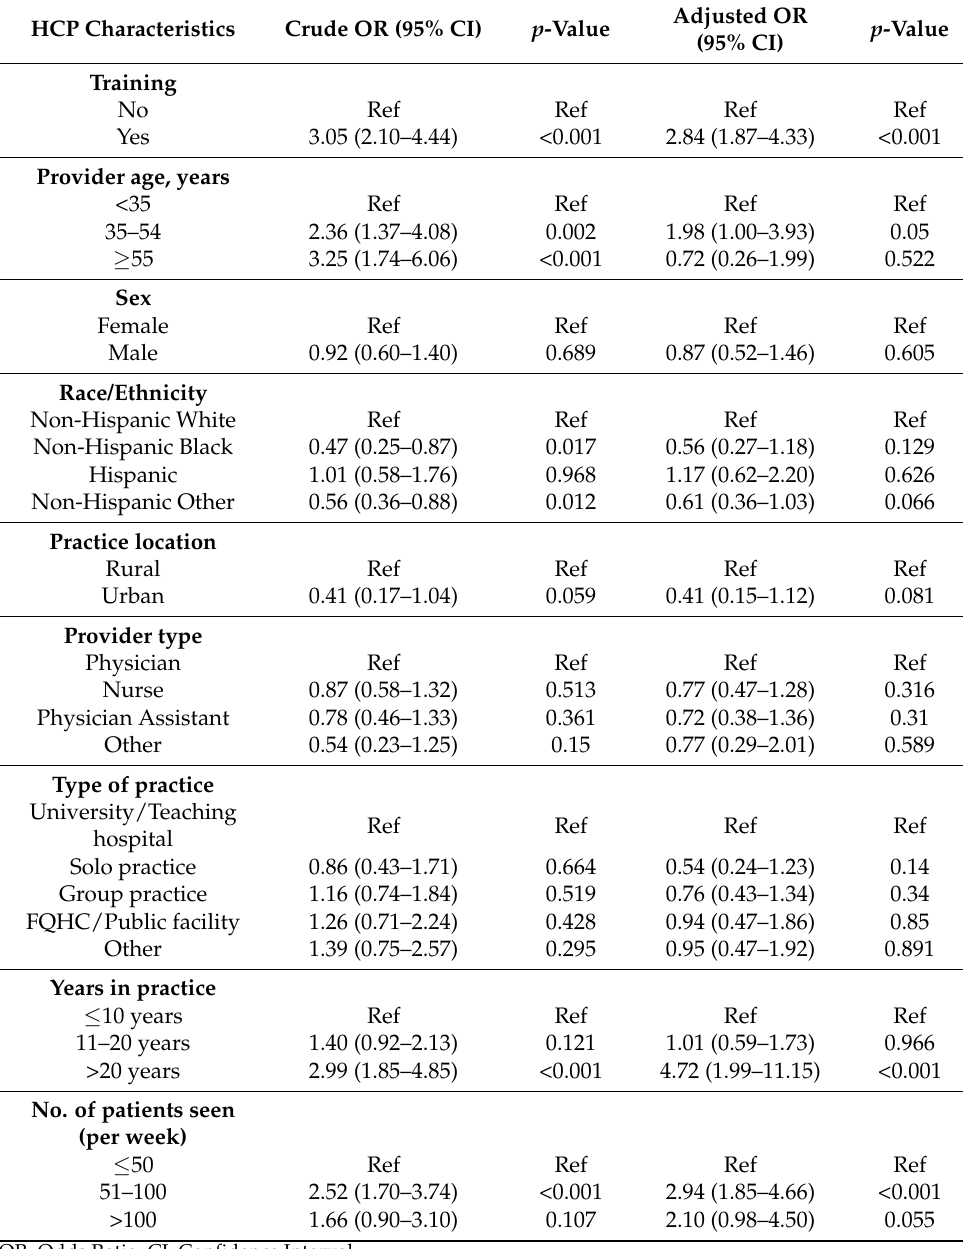
Table 3. Bivariable and multivariable logistic regression analyses of the association between HCPs’ training, socio-demographic, and practice-related factors with HCPs’ perceived self-efficacy in coun- seling HPV vaccine-hesitant adult patients (>18